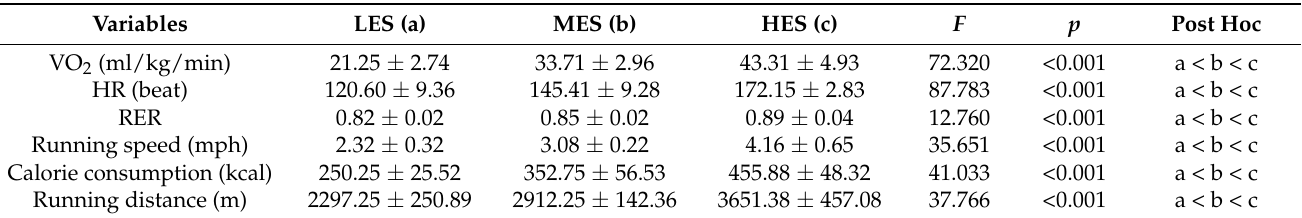
Table 4. The differences in VO 2 , HR, RER, running speed, running distance and calorie consumption according to exercise